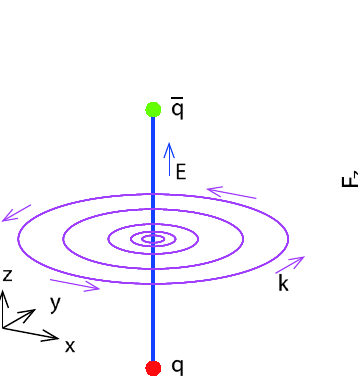
Fig. 4 [17] (Left panel) the relation among the chromoelectric field E , the induced magnetic current k μ , and the quark-antiquark pair q ¯ q